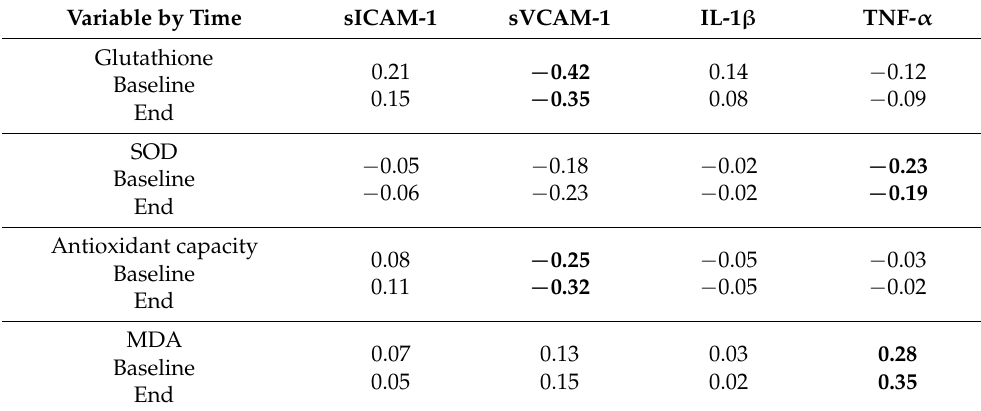
Table 3. Partial correlation coefficients among serum antioxidants, lipid oxidation, and inflammatory biomarkers adjusted for age and BMI at baseline and at the end of the